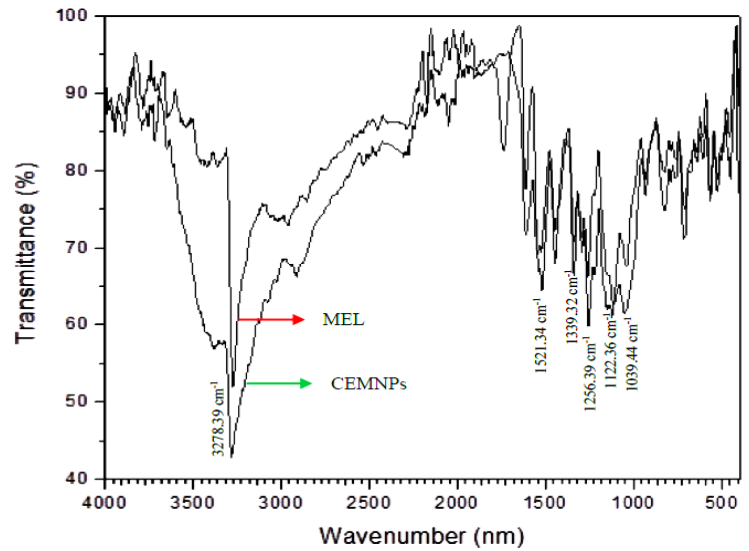
Figure 5. FTIR spectrum of meloxicam and chitosan-encapsulated meloxicam nanoparticles (CEMNPs).